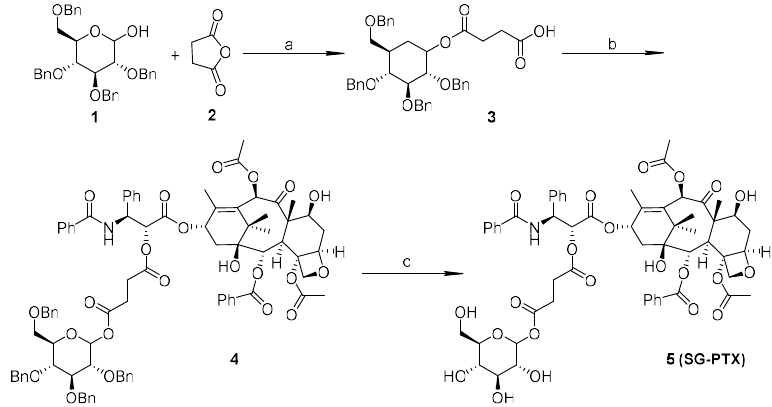
Figure 1. Chemical structure of paclitaxel.